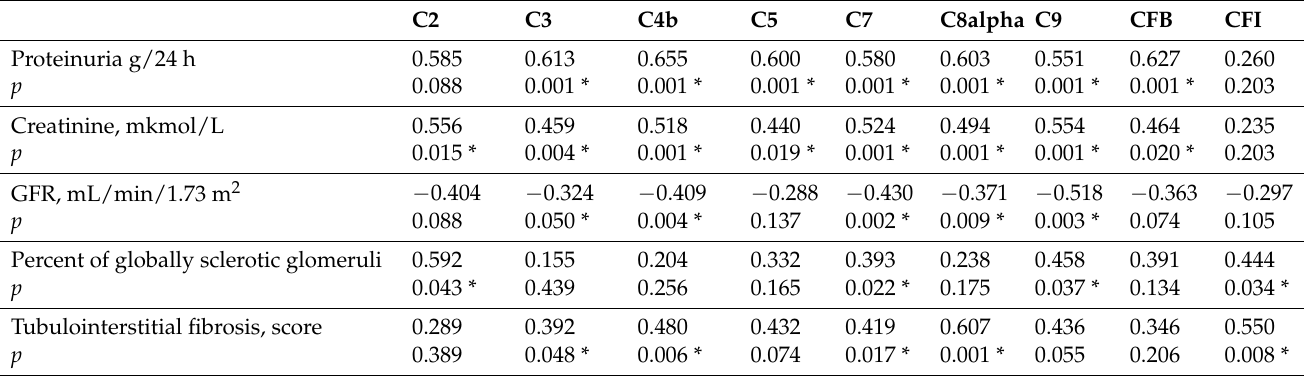
Table 3. Correlations (Spearman’s rho and p -value) between level of urinary excretion of complement components and degree of glomerulosclerosis. Levels of complement components in urine were determined by LC/MRM mass spectrometry (n =